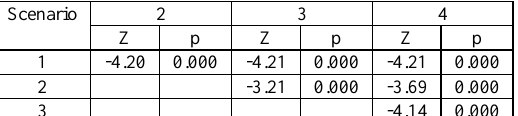
Table 8. Wilcoxon signed-rank test results (both hand)